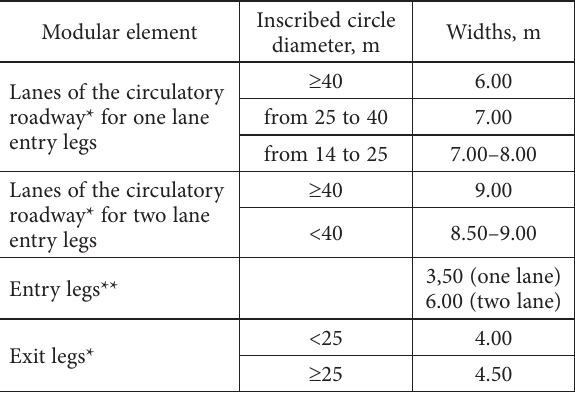
Table 3. Widths of modular elements – Italian standard Modular element